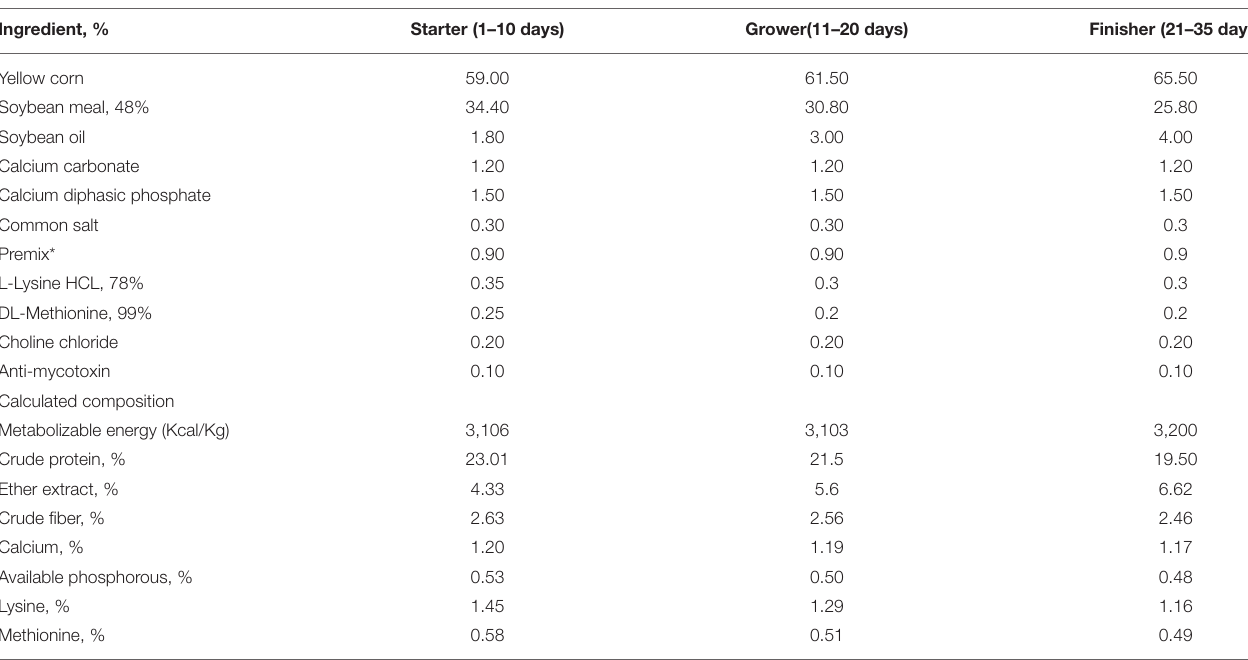
TABLE 1 | The ingredients and nutrient contents of basal